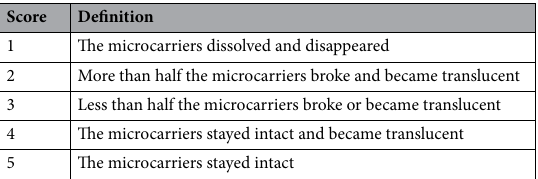
Table 2. Definition of scoring criteria for the microsphere appearance.